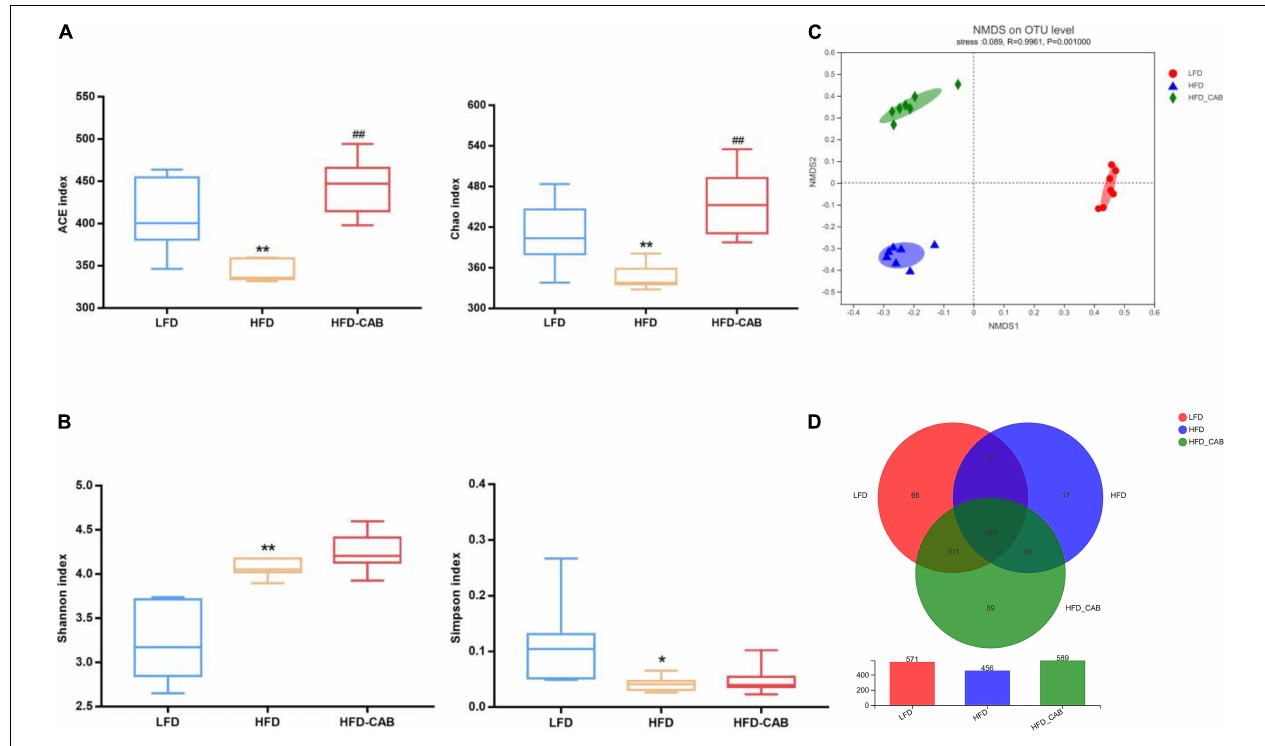
FIGURE 5 | Cooked adzuki bean modulates α and β diversity of gut microbiota in HFD-fed mice. (A) The community richness accessed by the ACE and Chao indexes, (B) The community diversity accessed by the Shannon and Simpson indexes, (C) Non-metric multidimensional scaling (NMDS) score plot based on Bray–Curtis, and (D) Venn diagram showing the OTUs shared by the mice from each group. Data presented as mean ± SEM, n = 7 per group. * P < 0.05 and ** P < 0.01 vs. LFD; ## P < 0.01 vs. HFD. LFD, low-fat diet; HFD, high-fat diet; HFD-CAB, high-fat diet supplemented with cooked adzuki bean.